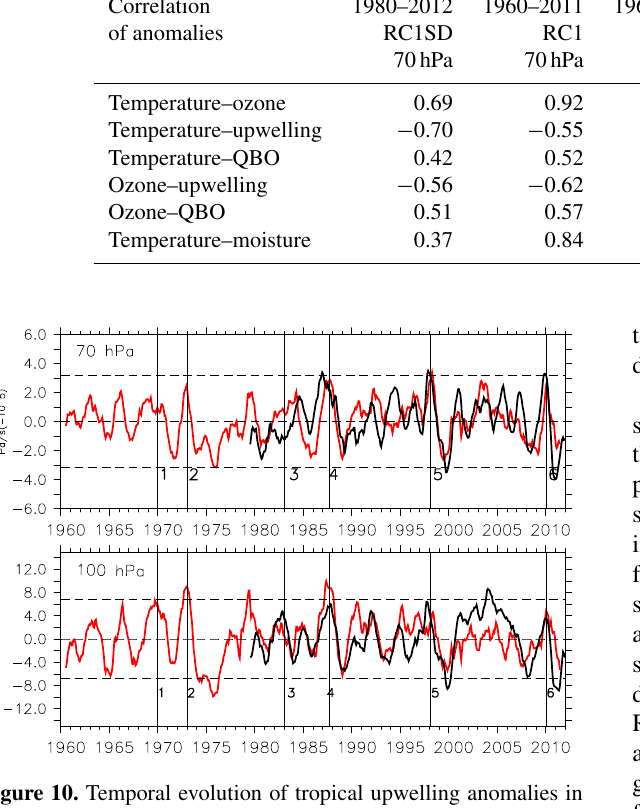
Table 2. Correlation of anomalies (detrended, deseasonalized) for RC1SD, RC1 and RC2 at 90 and 70hPa respectively. Correlation